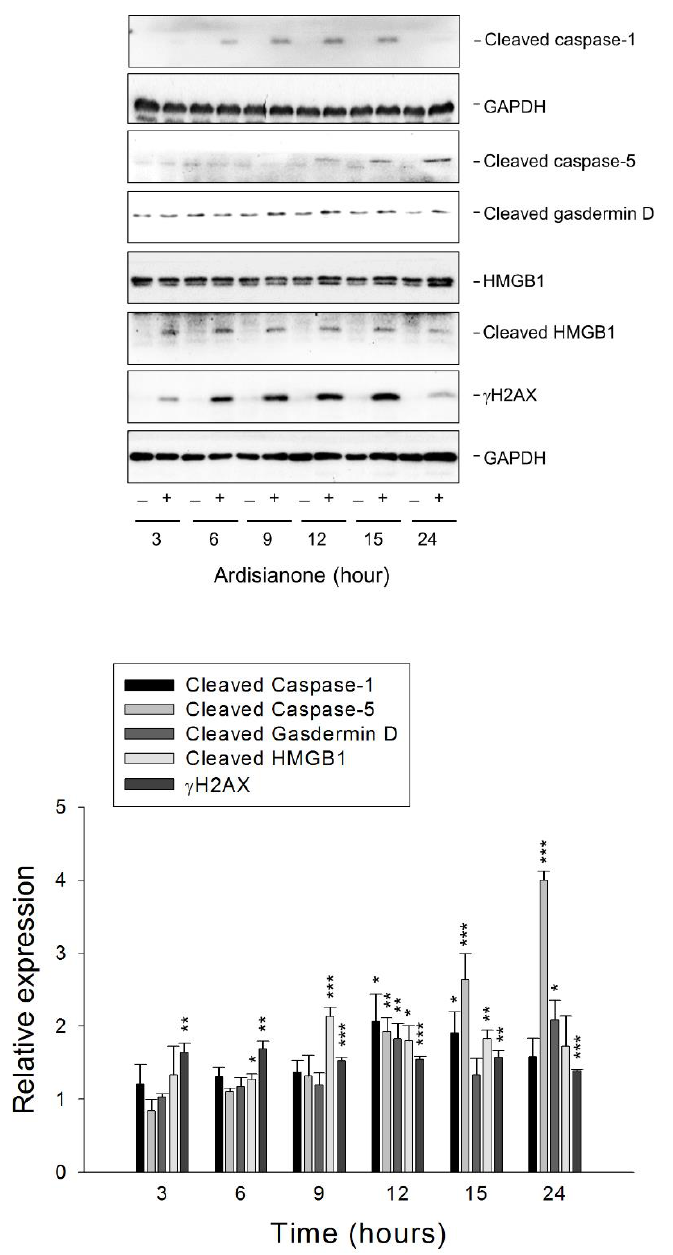
Figure 6. Effect of ardisianone on pyroptosis marker proteins. HL-60 cells were incubated with or without ardisianone (2 µ M) for the indicated times. After the treatment, the cells were harvested for the detection of protein expression using Western blotting analysis. The expression levels were quantified using Image Lab Software 6.0 (BIO-RAD), and protein expression relative to ardisianone- free control was demonstrated. Data are expressed as mean ± SEM of three determinations. * p < 0.05, ** p < 0.01, and *** p < 0.001 compared with the control.